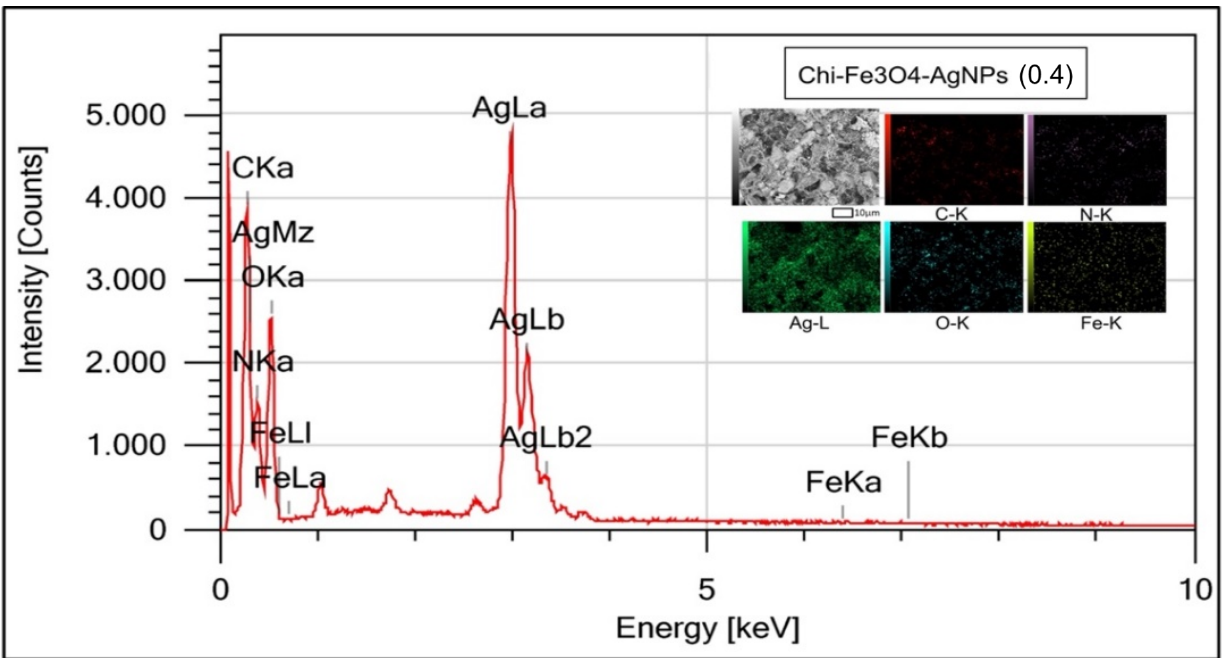
Figure 1. X-ray diffractogram pattern of chitosan, Fe 3 O 4 nanoparticles and Fe 3 O 4 @Chitosan-AgNP nanocomposites.